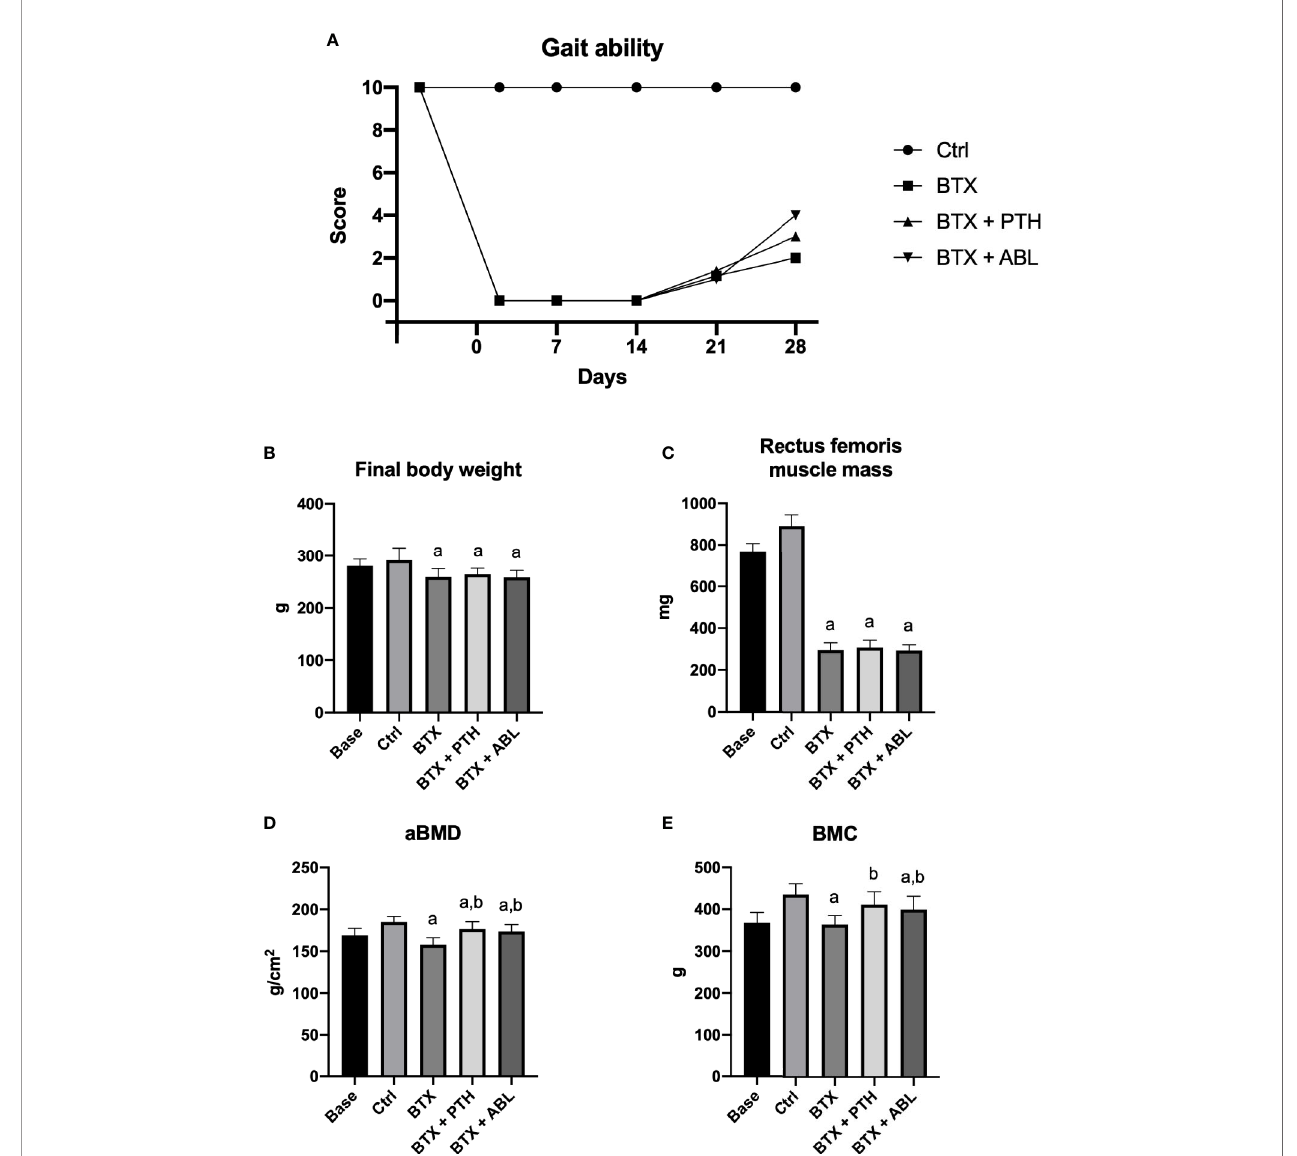
FIGURE 4 | (A) Gait ability score after right hindlimb injections with BTX. A gait ability score of 0 indicates profound paresis, whereas a score of 10 indicates normal gait ability. (B) Final body weight at study end. (C) Wet weight of rectus femoris muscle. (D) Femoral aBMD, bone mineral density. (E) Femoral BMC, bone mineral content. Data in (B – E) are presented as means ± SD. a: p < 0.05 vs. Ctrl. b: p < 0.05 vs.